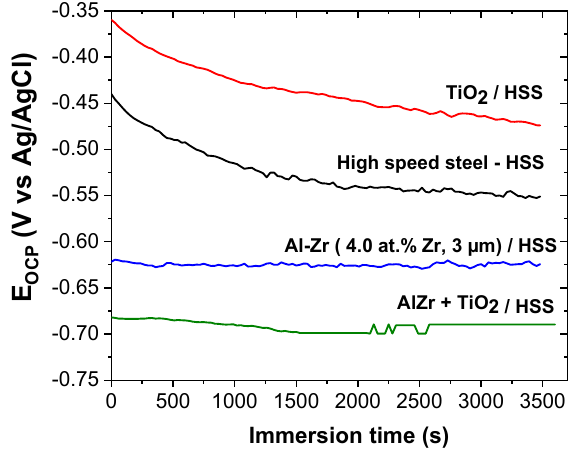
Figure 9. Evolution of OCP potential of steel coated with Al–Zr (4 at.% Zr) film and TiO 2 / Al–Zr bilayer films vs. immersion time in 5 wt.% NaCl.